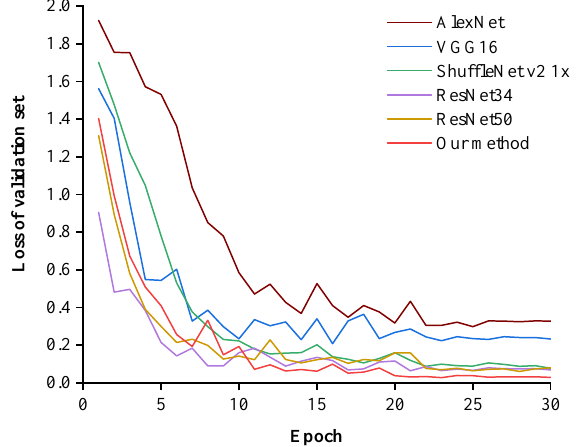
Figure 12. Comparison of loss of each model validation